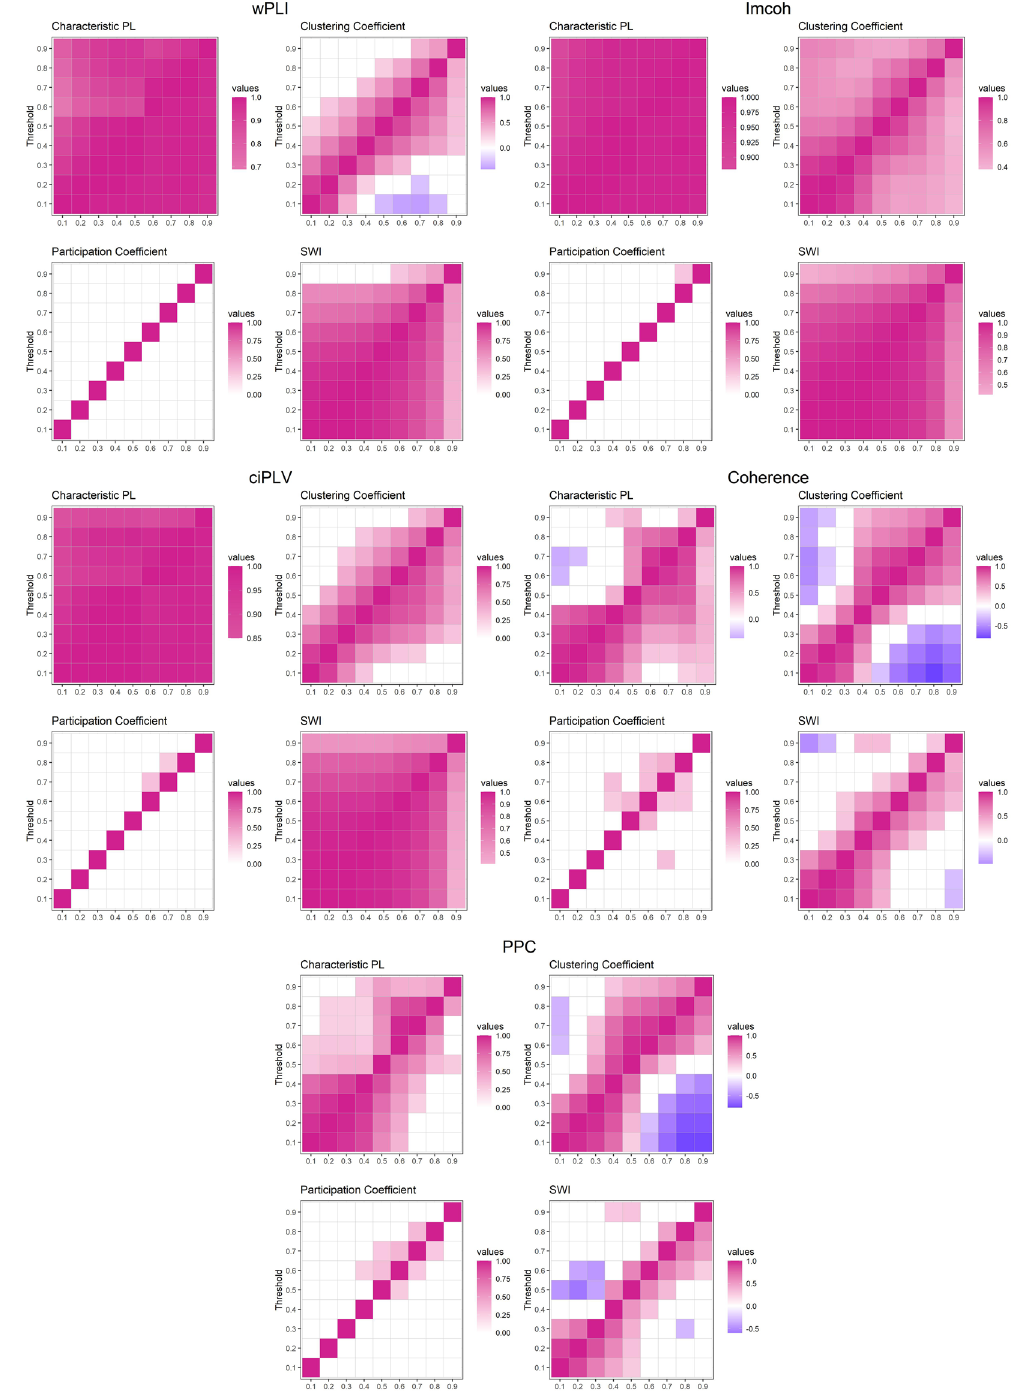
Figure 4. Correlation of graph measures on different thresholds. Five measures are presented in the following order (left-to-right, top-to-bottom): wPLI, imcoh, ciPLV, coherence, PPC. On each plot four measures are presented (left-to-right, top-to-bottom): Clustering Coefficient, Characteristic PL, Participation Coefficient, SWI. The utmost X-axis value on the right is the value obtained via OMST. Colored cells indicate the correlation between measures on two thresholds, purple color represents positive correlation, blue color represents negative correlation. White cells indicate absence of significant correlation. Transparency of color is related to the correlation strength, brighter color marks stronger correlations. ggplot2 3.3.6 (https:// ggplo t2. tidyv erse. org/) was used to create this